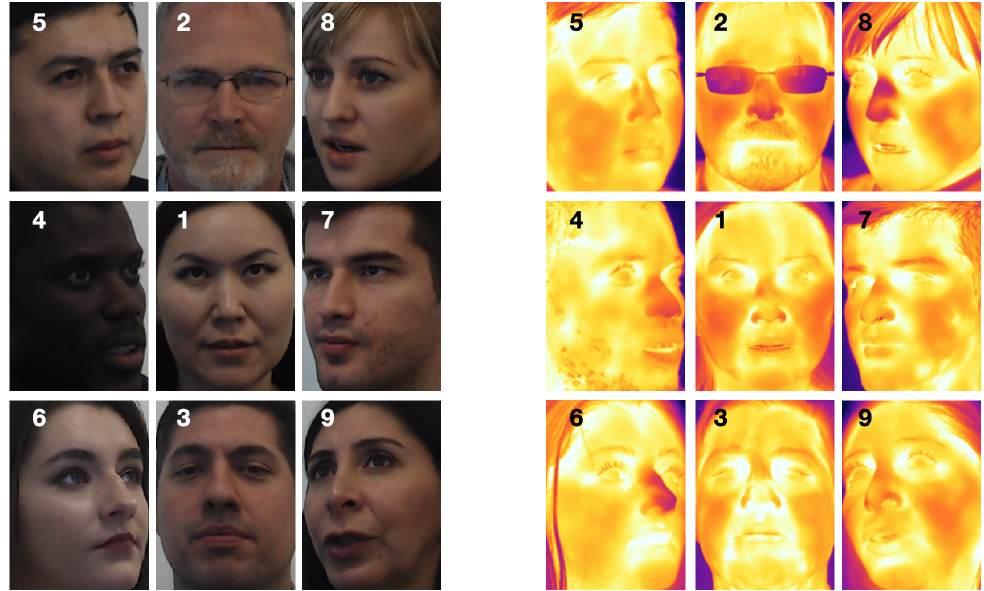
Figure 4. The pairs of visual and thermal facial images of nine subjects taken from the predefined nine